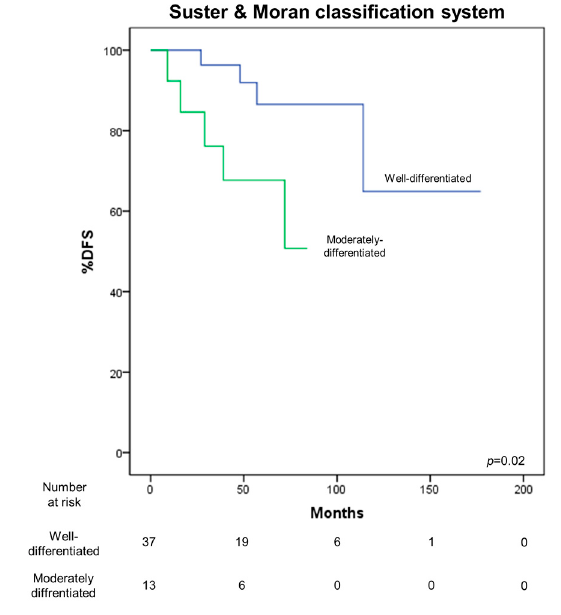
Figure 5. Correlation between DFS and Suster and Moran classification system.